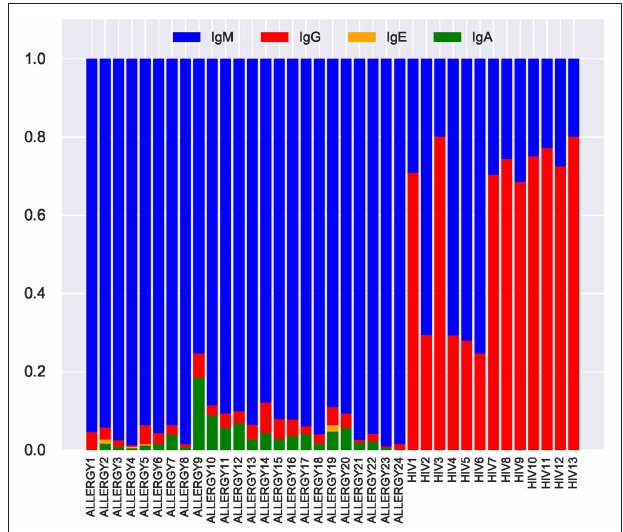
FIGURE 8 | Fractions of IgM, IgG, IgE, and IgA isotypes representing tandem CDR3s in the repertoires from the ALLERGY and HIV datasets.